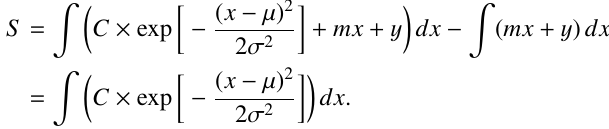
overall count rate decrease. In this example, the data collected in the first three time bins is used to set the energy interval to [190.0 keV, 199.0 keV] to filter out the peaks near 188.5 keV and 201 keV. The interval chosen attempts to include as much background as possible; without including neighboring